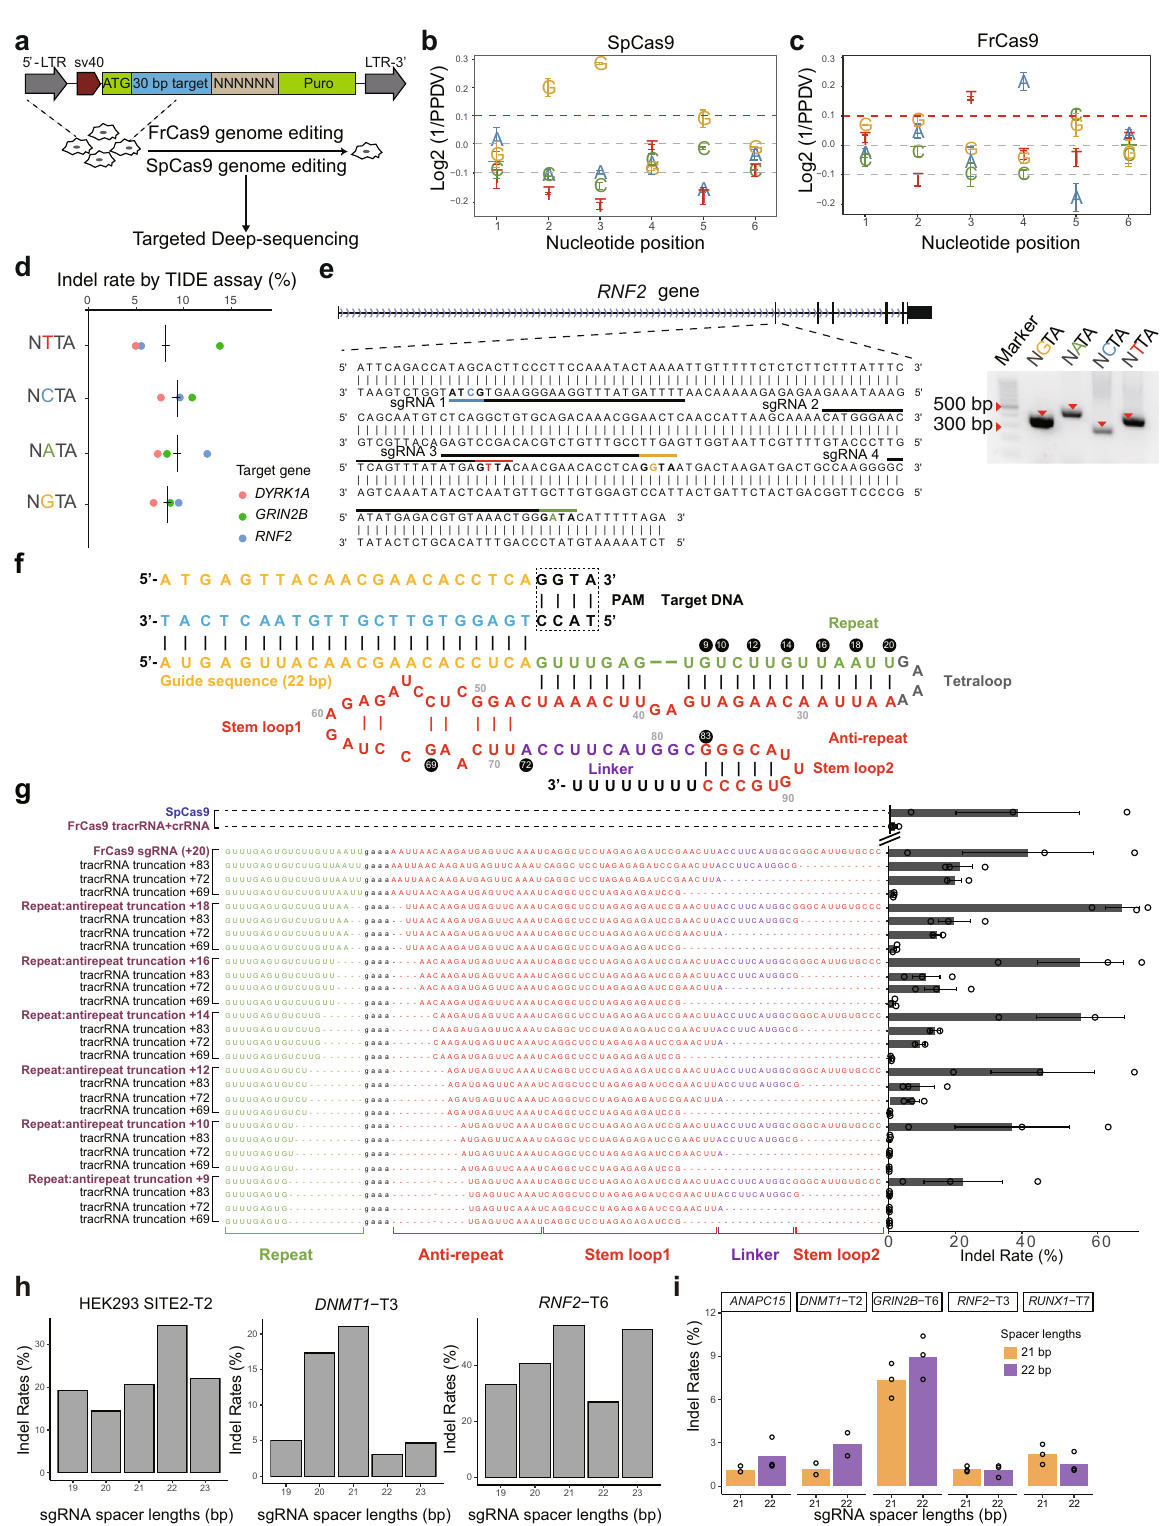
tracrRNA tails decreased the ef fi ciency of FrCas9 dramatically (Fig. 2g). Meanwhile, the truncation of 3 ′ crRNA affected the cleavage ability modestly when truncated from + 18 to + 12 (Fig. 2g). The gene editing by FrCas9 at other two endogenous sites ( GRIN2B -T3 and GRIN2B -T9) con fi rmed above conclusions (Supplementary Fig. 5). Notably, in RNF2 site, the